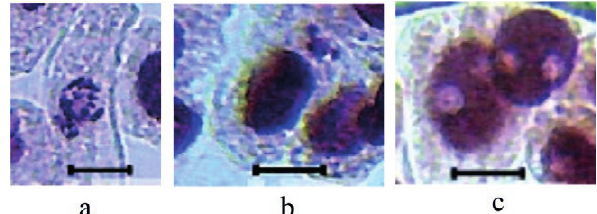
Figure 3. Types of nuclear abnormalities of A. cepa root tip cells after treatment with Ni, encapsulated E. acoroides leaves extract and combined Ni and encapsulated extract. a. nuclear fragmentation; b. micronucleus; c. nuclear lesion. Scale